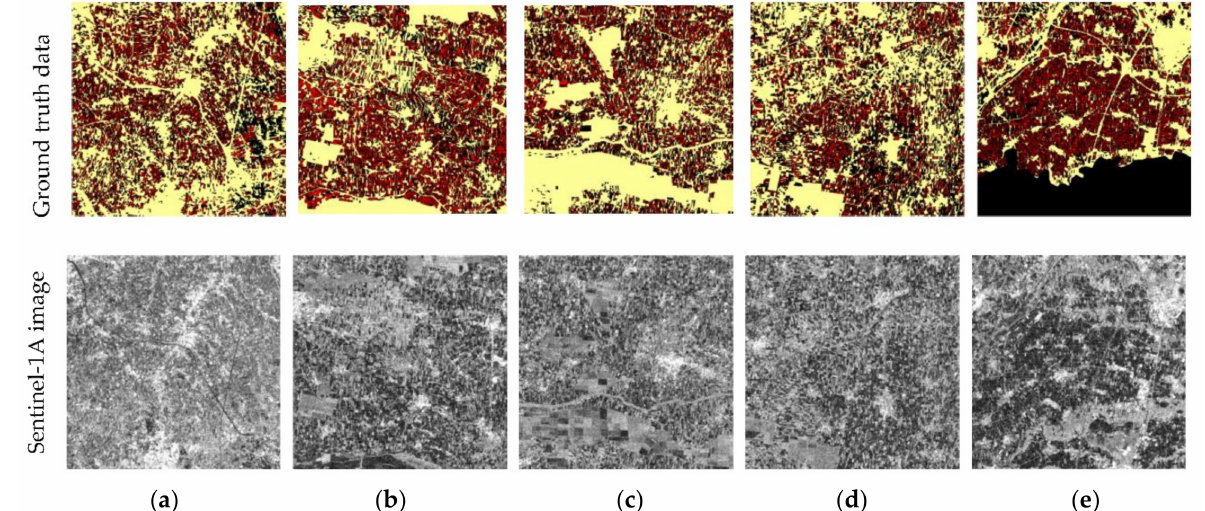
Figure 9. Sentinel-1A image and corresponding ground truth data of the five selected regions. ( a – e ) corresponding to regions 1–5 in Figure 8, respectively. Rice pixels are shown in red, non-rice pixels in yellow and non-interesting pixels in black.